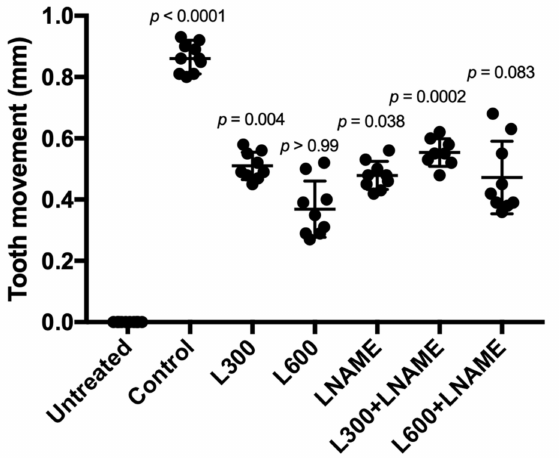
Figure 1. Orthodontic tooth movement. The orthodontic force was applied to move the right upper first molar towards the incisor. Fourteen days following appliance insertion orthodontic tooth movement was measured directly in the mouth to reveal the distance between the first and second right molars and confirmed on a plaster replica. Multiple comparisons were based on Kruskal–Wallis test and Dunn’s correction. p -values show the changes compared to the normal non-OTM group. Comparison of L300/L600 with L300/L600 + LNAME are all p > 0.99 and thus not shown in Figure 1. Data are shown as dot blot with median and 95%